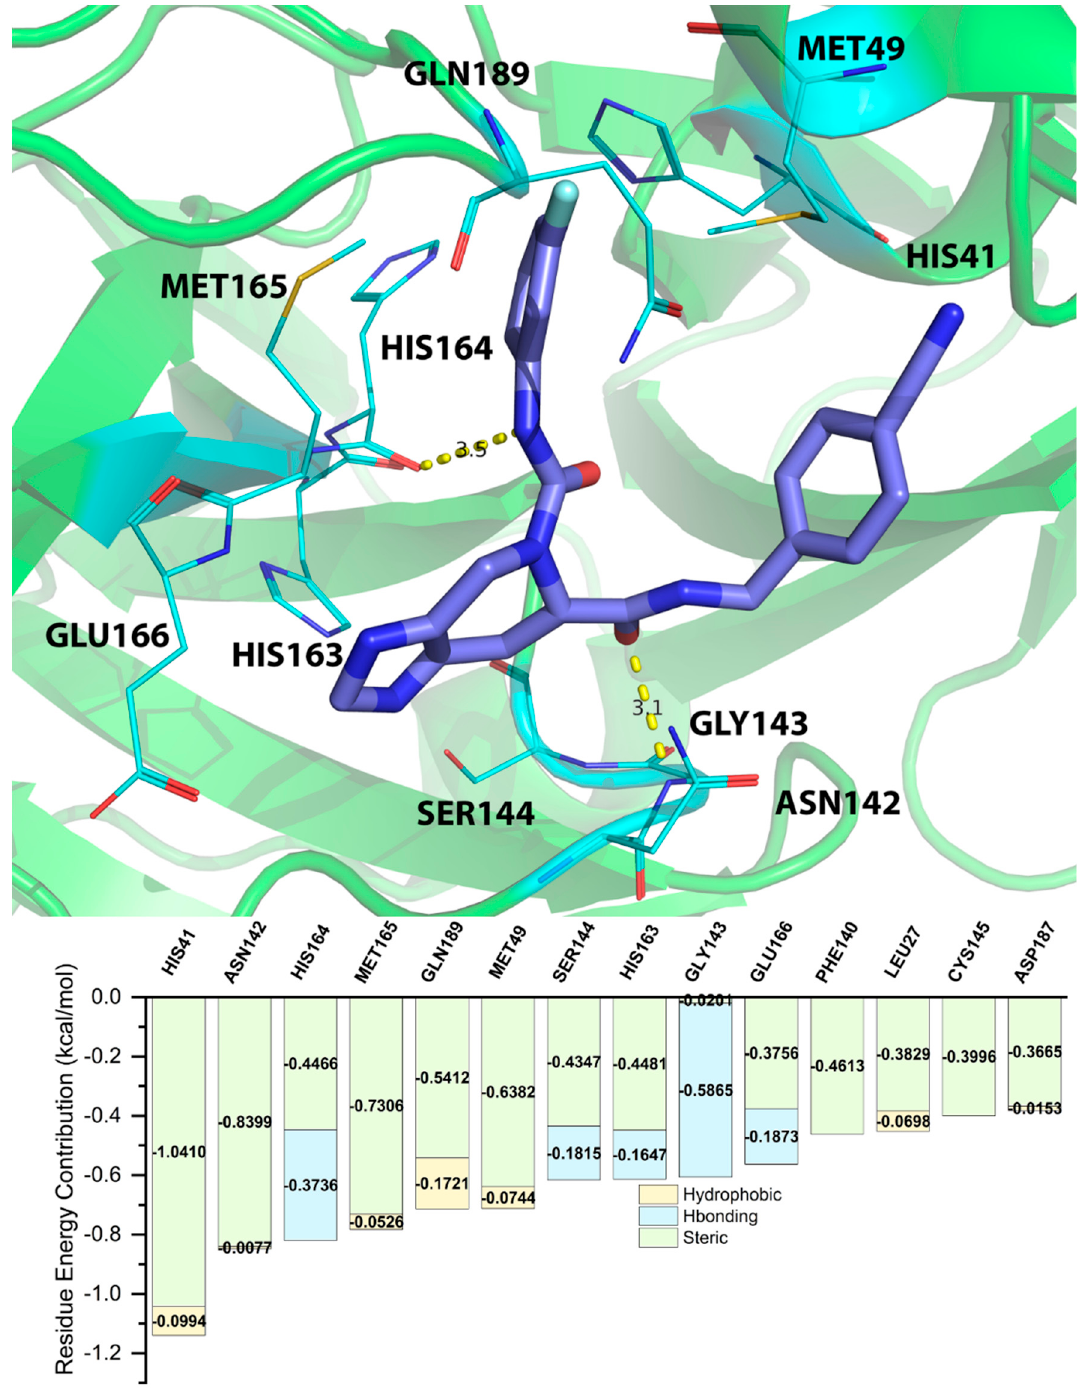
Figure 2. Binding poses between ZINC15676170 and 3CL pro of SARS-CoV-2 predicted by MD simulation and residue energy contribution between ZINC15676170 and 3CL pro of SARS-CoV-2 predicted by MCCS.